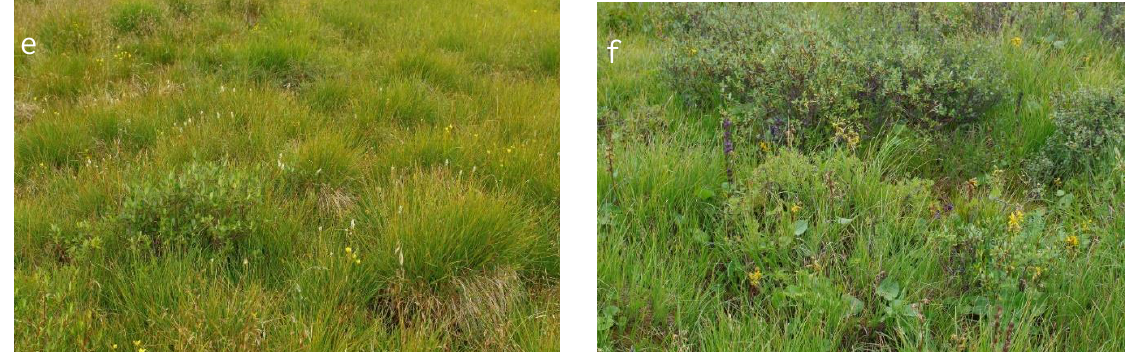
Figure 13. The main types of mire ecosystems at the Adyr-Khem key site: ( a ) — dwarf birch- Sphagnum ridges; ( b ) — plant community with dwarf willow ( Salix rectijulis) and green moss ( Paludella squarrosa) ; ( c ) — plant community with Comarum palustre ; ( d ) — plant community dominated by cotton grass ( Eriophorum polystachyon) ; ( e ) — hummock fen dominated by Deschampsia cespitosa ; ( f ) — willow-herb-green moss community (photos by Volkov, 5 August 2021).